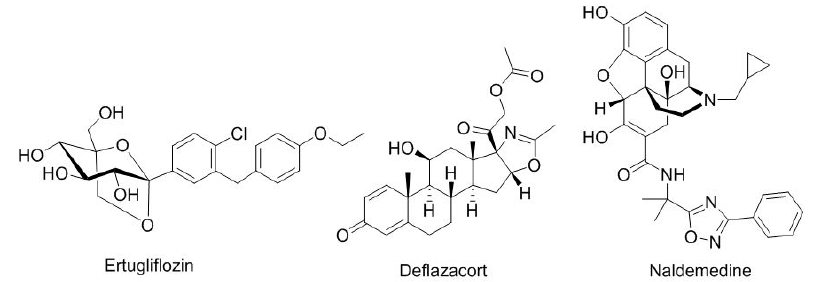
Figure 5. Structure of drugs inspired by natural products.